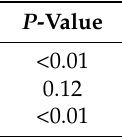
Figure 2. Non-invasive fibrotic markers in patients with mild and moderate inflammation (non A3) and with severe inflammation (A3). ( a ) Total patients; ( b ) NASH patients; ( c ) AIH patients; ( d ) PBC patients. The bar graph represents the mean values, and the error bar represents standard deviation values. AAR, AST to ALT ratio; APRI, aspartate aminotransferase to platelet ratio index; FIB4, fibrosis index based on four factors; WM, Wisteria floribunda agglutinin-positive human Mac-2-binding protein; IgA, immunoglobulin A; HA, hyaluronic acid; LS, liver stiffness; * p < 0.05. Table 2. Relationships between histological staging of fibrosis (F stage) versus grading of activity (A grade) in patients with nonalcoholic steatohepatitis (NASH), autoimmune hepatitis (AIH), or primary biliary cholangitis (PBC). Pearson correlation coefficient between F stage and A grade was indicated by r . r P -Value